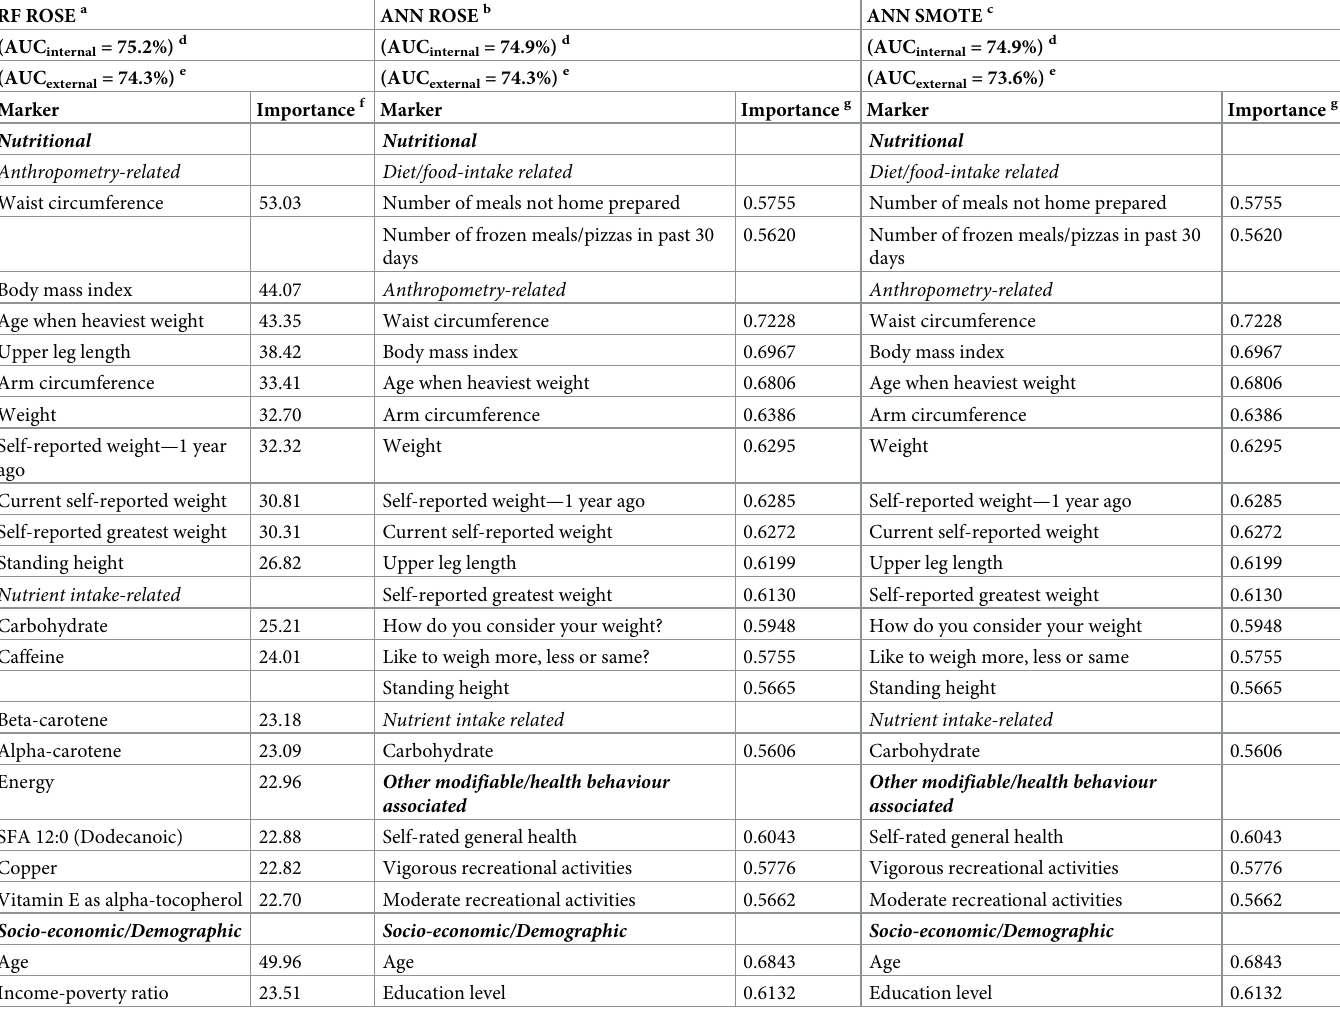
Table 2. Nutritional and other markers of undiagnosed type 2 diabetes identified by best-performing ANN and RF models. RF ROSE a ANN ROSE